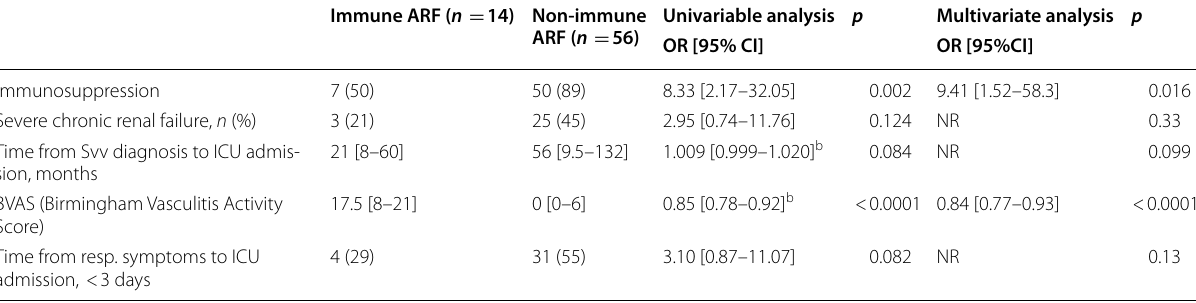
Table 5 Univariable and multivariate analyses of factors associated with a non‑immune cause in the subgroup of patients with ARF complicating a known Svv (n 70) a =